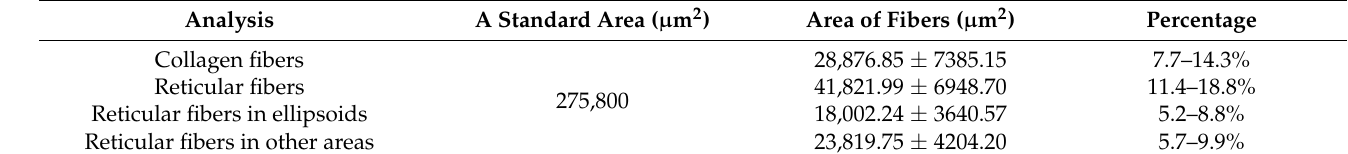
Table 1. The fibrous skeleton of spleen analyzed by IPP 6.0.